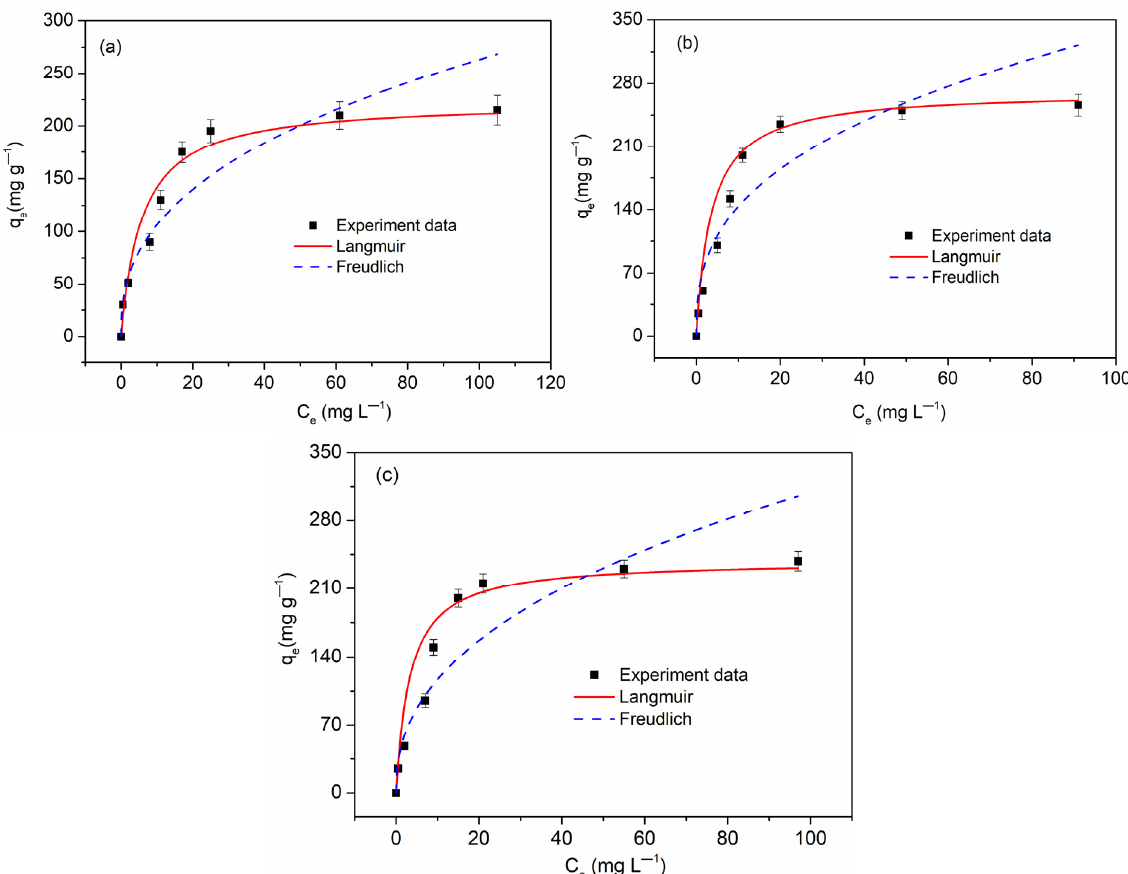
Figure 7. Isotherm of Cu(II) adsorption on ( a ) FBPC 2.5-900-1% , ( b ) FBPC 2.5-900-2% , and ( c ) FBPC 2.5-900-4% . Adsorbent dose = 0.35 g L − 1 ; shaking time = 90 min; temperature= 298K; pH = 5.0 ; shaking speed = 300 rpm; and initial Cu(II) concentration = 10–200 mg L − 1 . Table 3. Kinetic adsorption parameters for the process of Cu(II) removal by the FBPC samples.